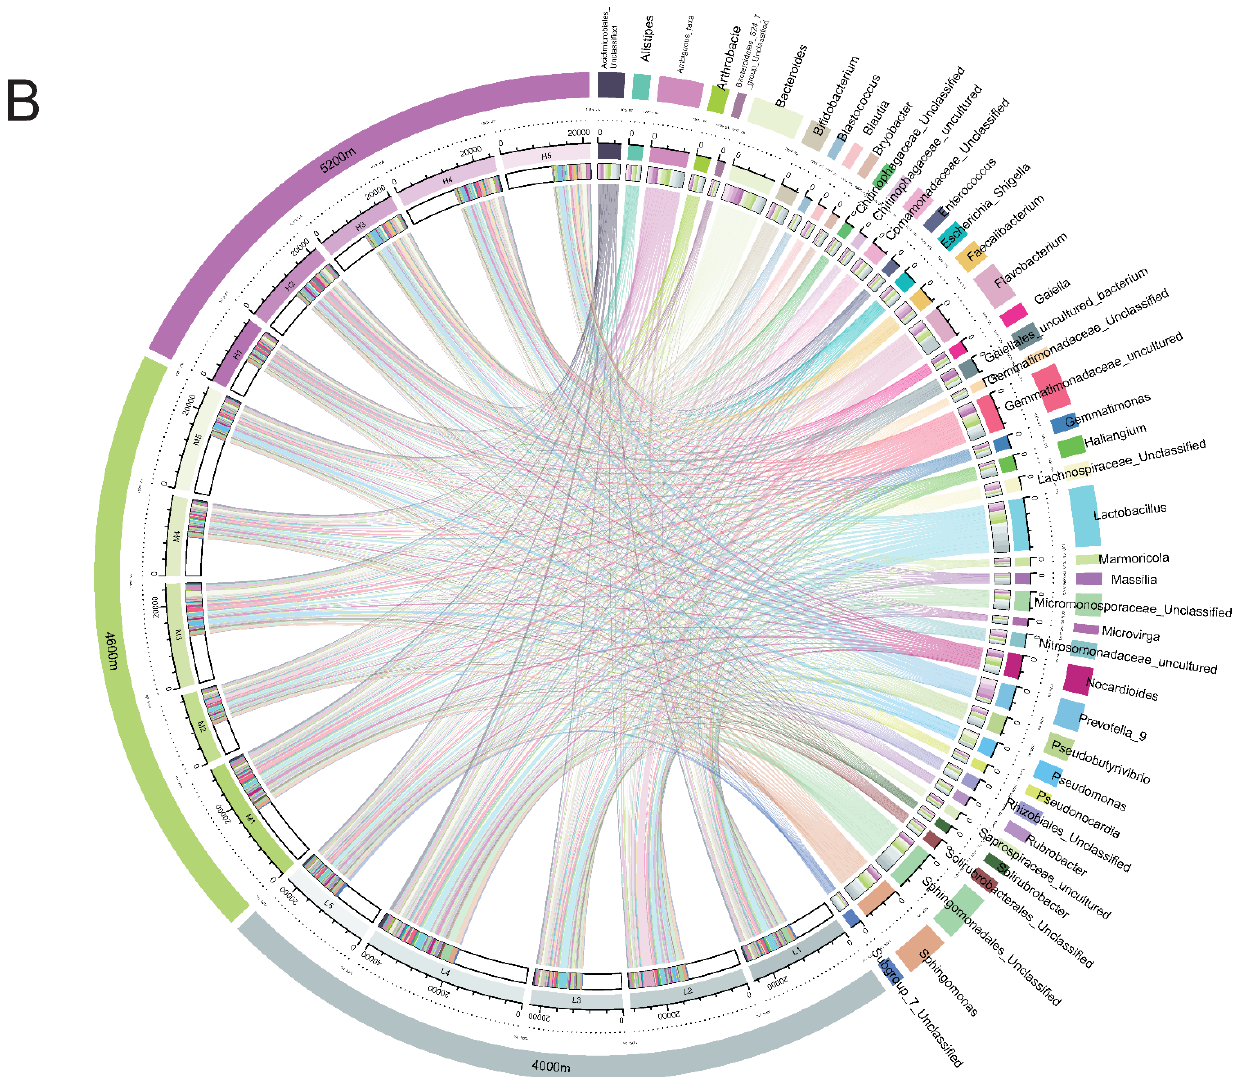
Figure 15. Circos circular plot of the bacterial community ( A ) at the phylum level and ( B ) at the genus level.